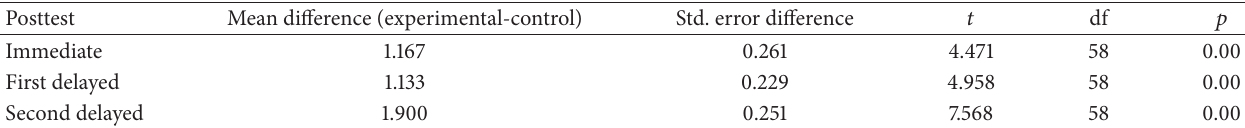
Table 11: Independent samples 𝑡 -tests for the receptive posttests.